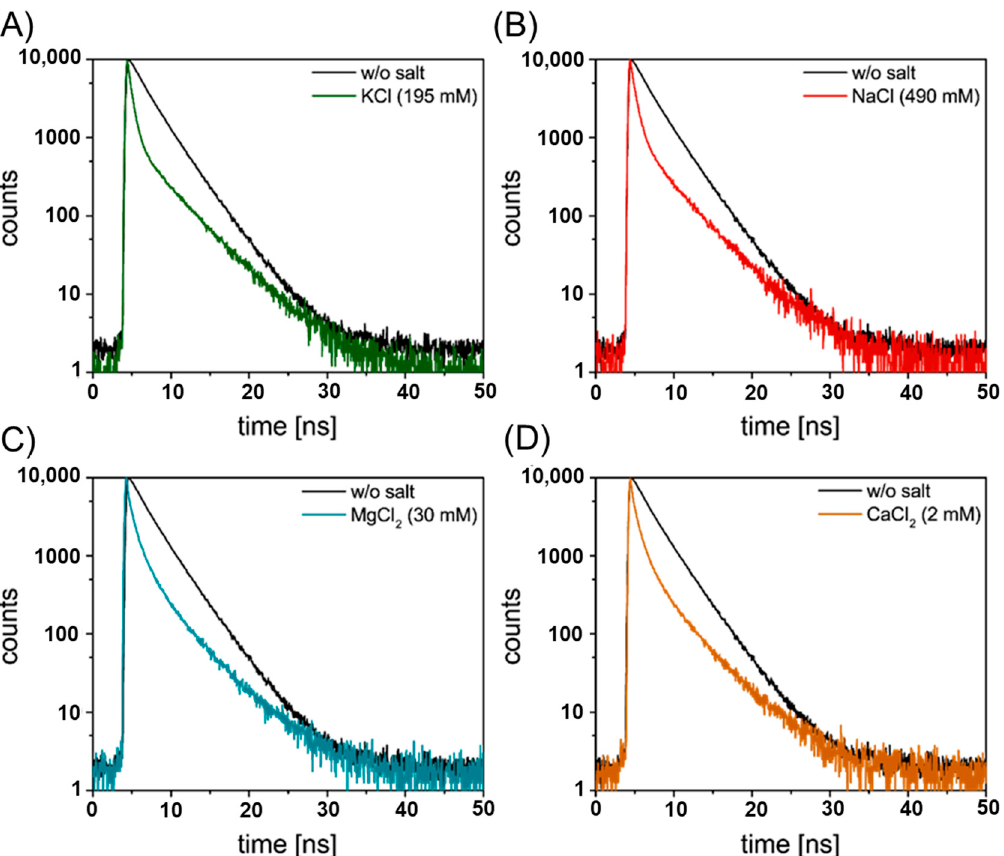
Figure 2. FAM fluorescence decay curves (c(DNA) = 5 nM, λ ex = 490 nm, λ em = 520 nm) for RevHumTel in presence of different salts ( A ) KCl (c = 195 mM), ( B ) NaCl (c = 490 nm), ( C ) MgCl 2 (c = 30 mM) and ( D ) CaCl 2 (c = 2 mM). The fluorescence decay curves have been fitted tri-exponentially to determine different FAM-Cy3 distances (5 ′ -3 ′ -end distances) which help identify different G-quadruplex structures in presence of different salts.